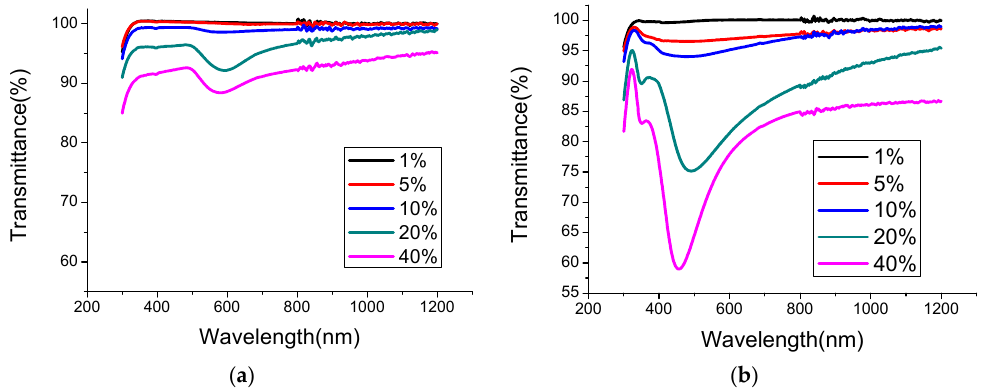
Figure 1. The transmittance of ( a ) Au and ( b ) Ag nanoparticles at concentrations of 1%, 5%, 10%, 20% and 40% on glass surface.